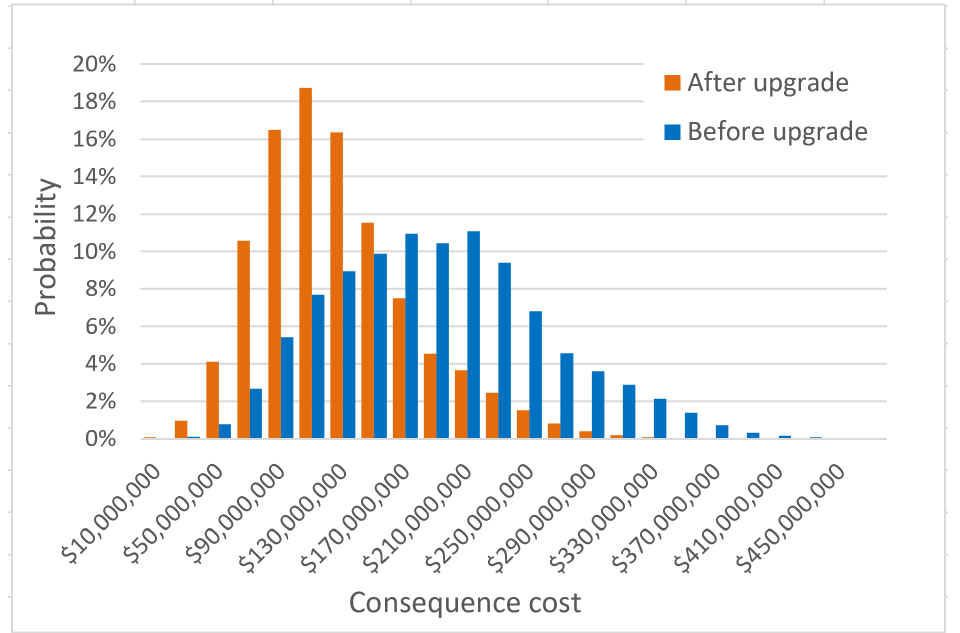
Figure 12. Comparison of “before upgrade” (blue) and “after upgrade” (orange) probability distributions of the outage consequence